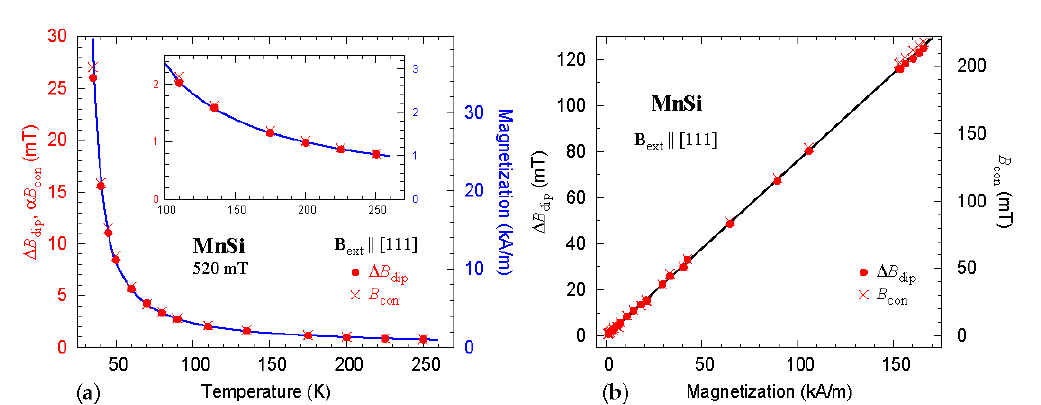
Figure 5. ( a ) comparison of the parameter ∆ B dip characterizing the muon dipole field (red bullets), the contact field ( B con , red crosses) and the sample bulk magnetization (blue line), as a function of temperature. The different parameters have been measured in a field of 520 mT applied along the [111] crystal axis. The inset displays the high temperature details. The coefficient α = 0.585 in the vertical axis label is the ratio ∆ B dip / B con expected from the experimental data refinements published in [8,9]; ( b ) the same parameters ∆ B dip and B con are plotted versus the bulk magnetization. The points correspond to data recorded in various temperatures and fields up to 7.5 T. The scales for the ∆ B dip and B con axes differ by the factor α = 0.585. The full line represents the linear dependence expected if no muon-induced effect is